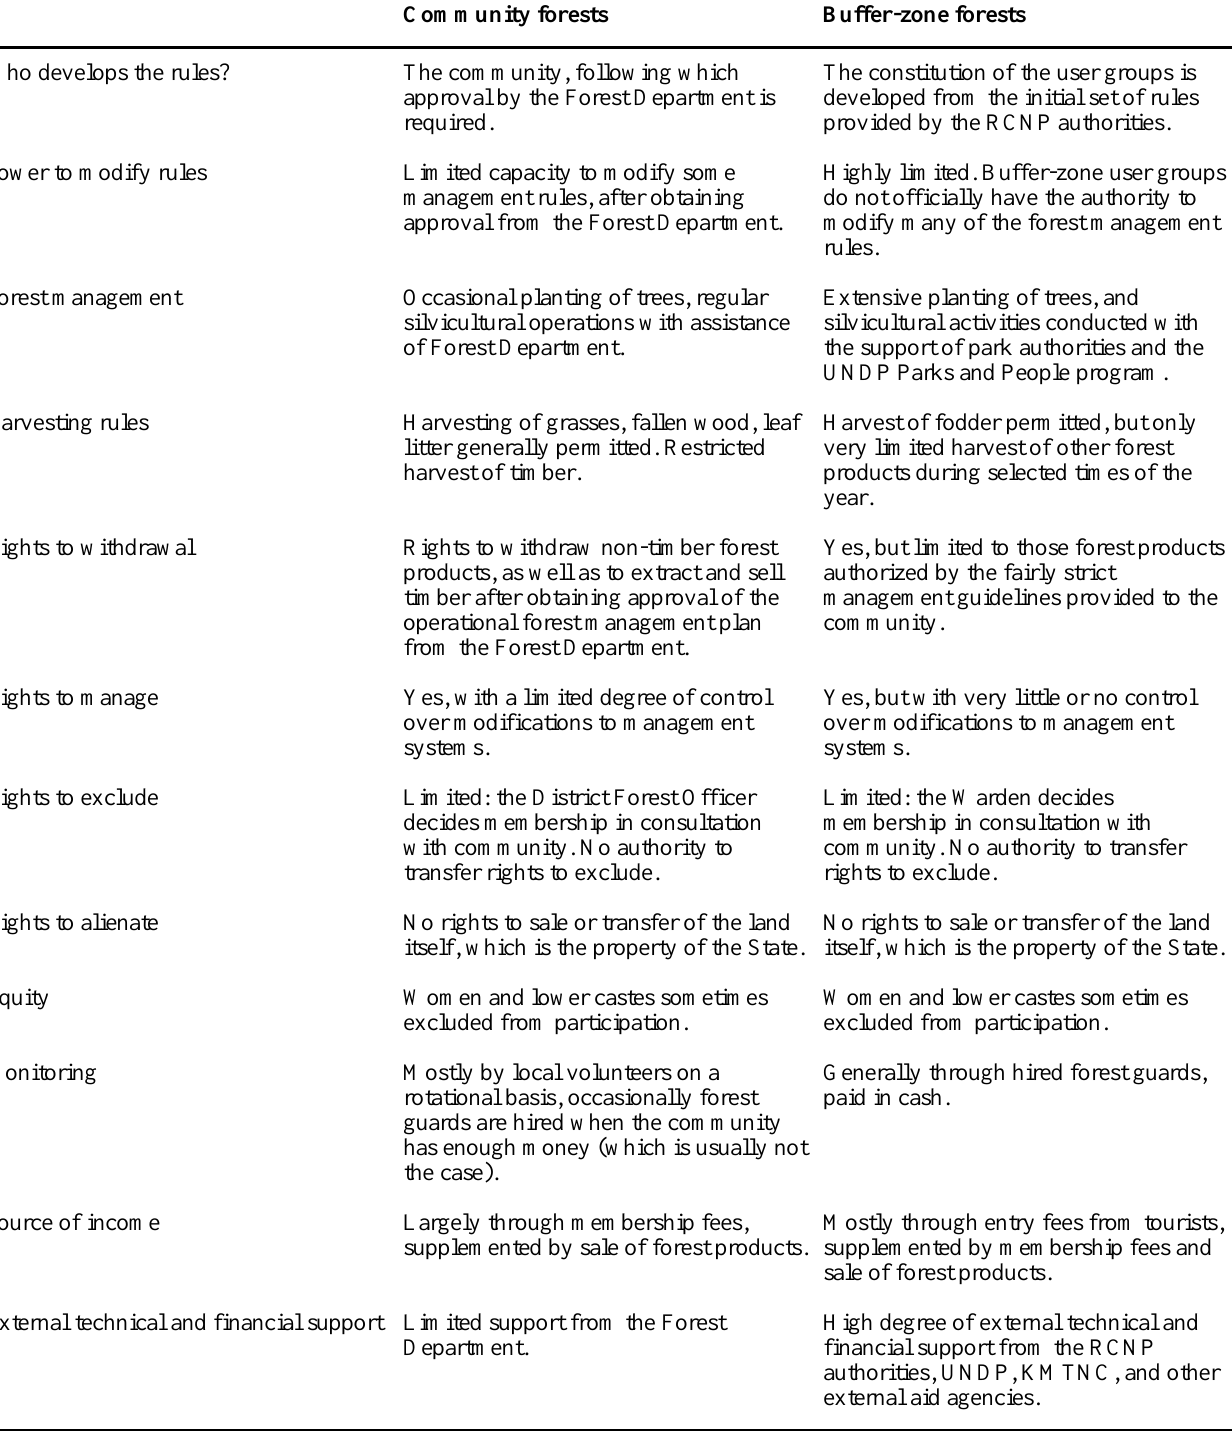
Table 1 . Comparison of the buffer-zone and community-forest management regimes in terms of operational rules, property rights, sources of income, and external